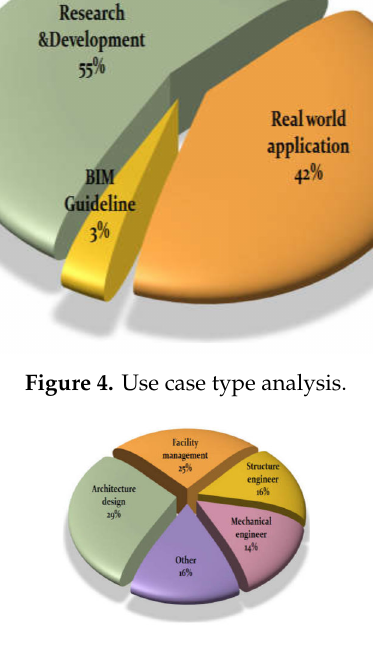
Figure 5. Target discipline